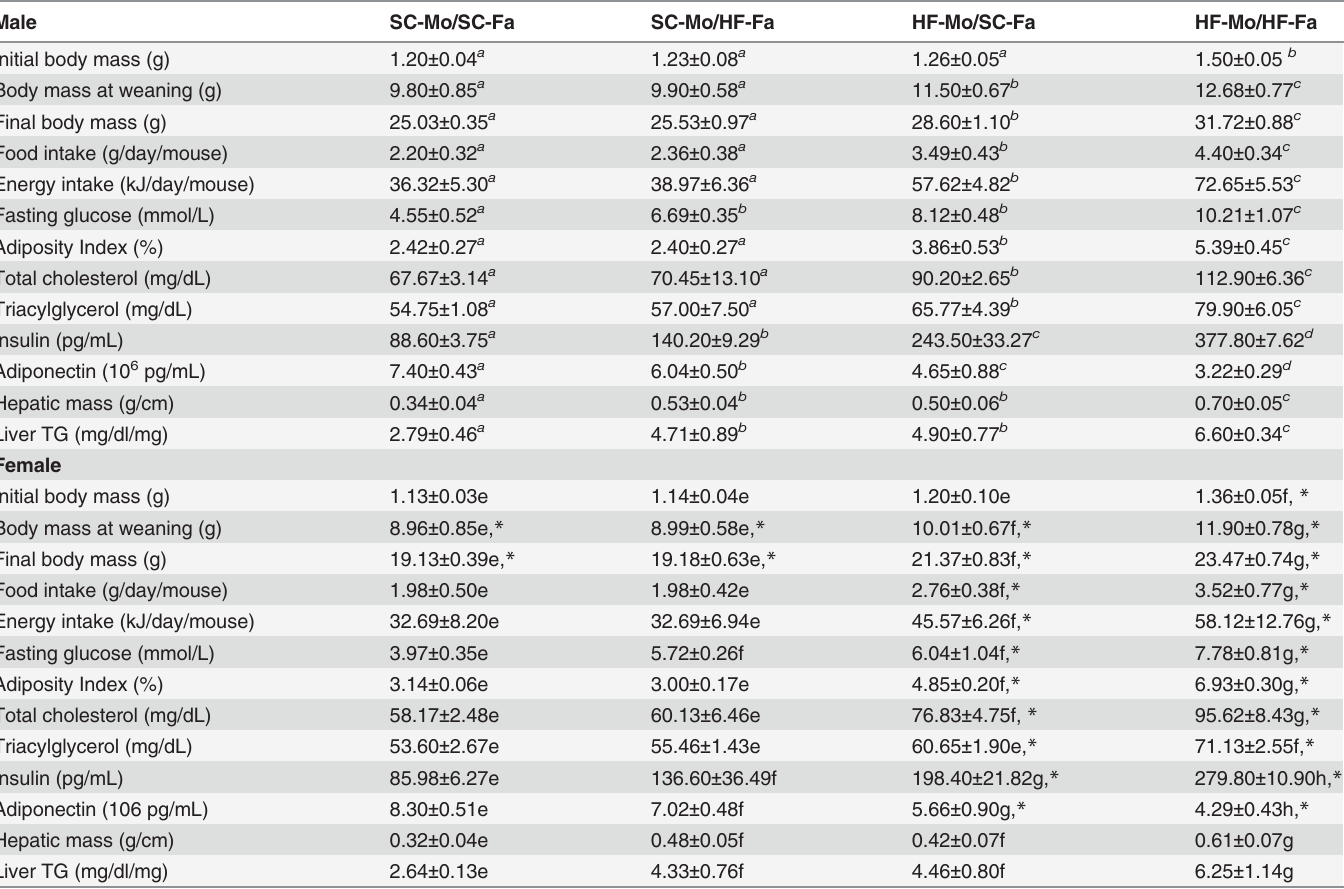
Table 4. Characteristics of male and female offspring of fathers and mothers that received standard chow (SC) and/or high-fat (HF) diet.